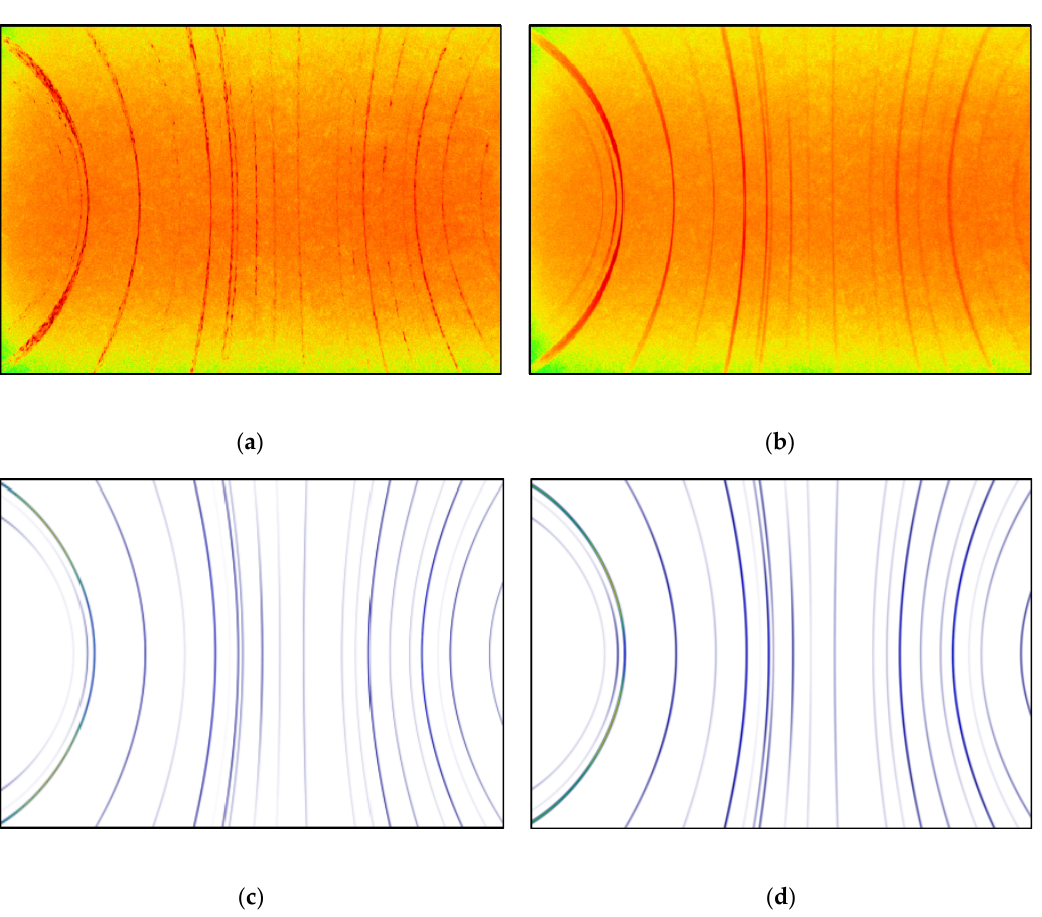
Figure 5. Image plate readouts of the scattered X-ray intensity distribution of the ( a ) as-received and ( b ) the 23% tensile-deformed specimen measured with ND-A orientation. Corresponding intensity distributions calculated by X-TEX with the texture parameters obtained from the experimental data for the ( c ) as-received and ( d ) the 23% tensile-deformed specimen (note that the position of the image plate is different from the position of the detector in Figure 1). Table 2. The ϕ 1 , Φ and ϕ 2 Eulerian angles of the ideal orientation of the major texture components, the f r volume fraction of the random texture component and the FWHM describing the orientation spread of the major texture components calculated by